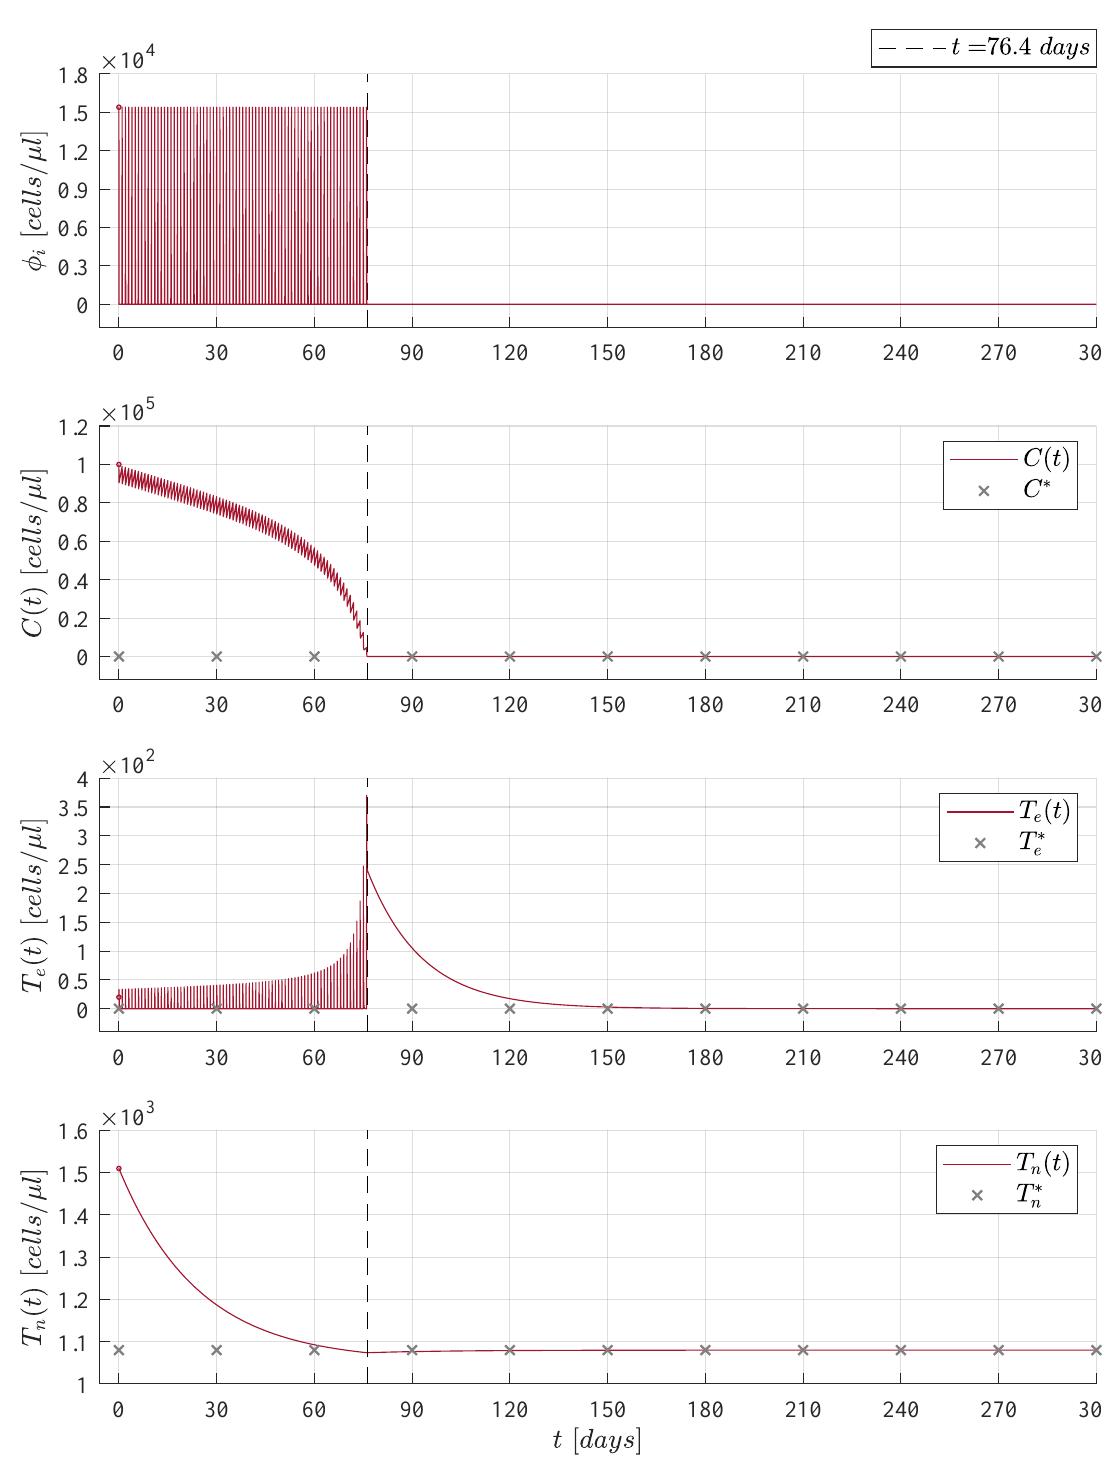
C max = 1 × 10 5 cells/ µ L. The cellular 3